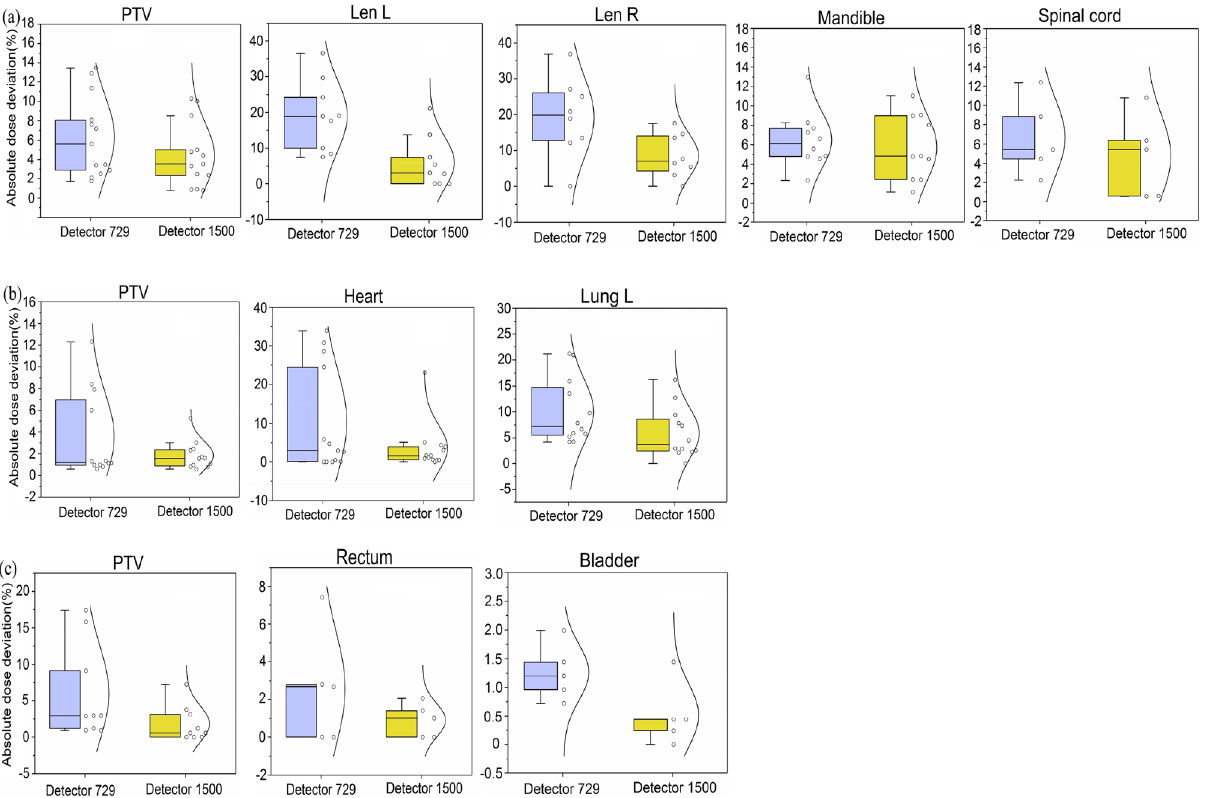
Figure 4. Absolute percent dose deviations in PTVs and partial OARs. (a) PTVs, left lens, right lens, left parotid gland, mandible, and spinal cord in head & neck cases. (b) PTVs, heart, and left lung in thorax cases. (c) PTVs, urinary bladder, and rectum in pelvic cases. The differences between individual values in 1500 cohorts were smaller than those in 729 cohorts, as shown in the boxplot and the points and lines of normal malization) as suggested by TG 218 guideline. As a result, the resuts of most stringent tolerance criteria were not significantly different from the 3%/2 mm tolerance criteria (Fig. 5m,n). This contradicts the hypothesis that all DLG-error cases may lead to a lower γ value. Dose deviations may occur at any time during the calculation and delivery process. The results showed that regardless of global or local normalization, γ values in IE cases were lower compared to NE cases in coalescence and SA cohorts. Dose error sensitivity in two spatial sampling sce- narios showed slightly different behaviors, and the potential effects of spatial resolution on γ value varied from case to case. Higher resolution cohorts had slightly greater areas under ROC curve than those in lower resolution cohorts (Fig. 5j,l). However, higher resolution cohorts showed a greater statistical difference between NE and IE cases ( P = 0.001, 0.003, 0.022 vs P = 0.006, 0.004, 0.055). Therefore, the potential for improving the detectability of dose error was detected by increasing spatial resolution and sampling points in coalescence cohorts.